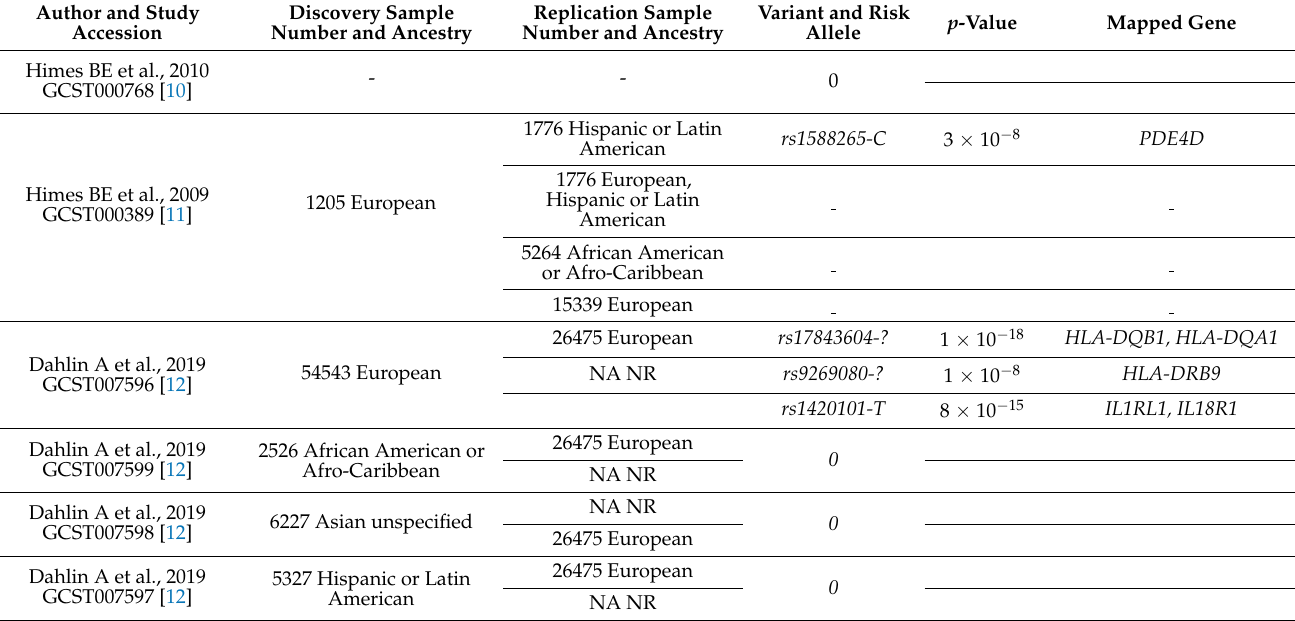
Table 1. Presentation of the results of 8 significant meta-analyses concerning genetics in asthma susceptibility published on the GWAS Catalog and the loci associations that were